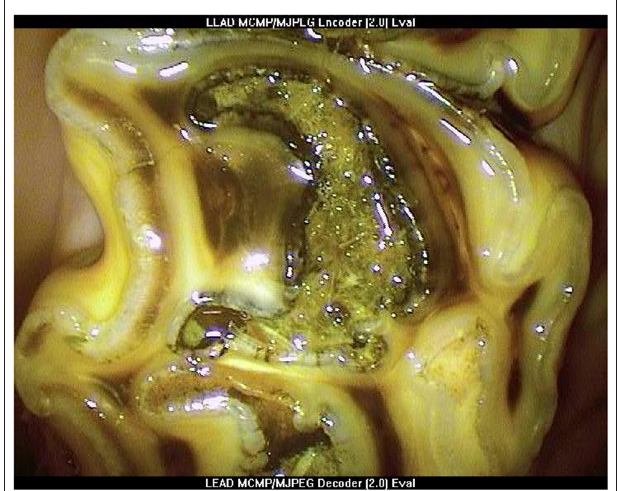
FIGURE 1 | Oroscopic image of Grade 3 mesial infundibular caries of a Triadan 109 tooth at presentation.